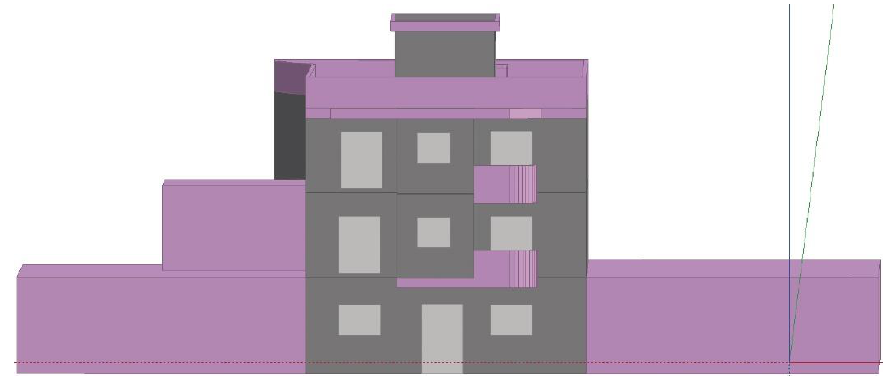
Figure 6. Modelling of the building performed using Design Builder.